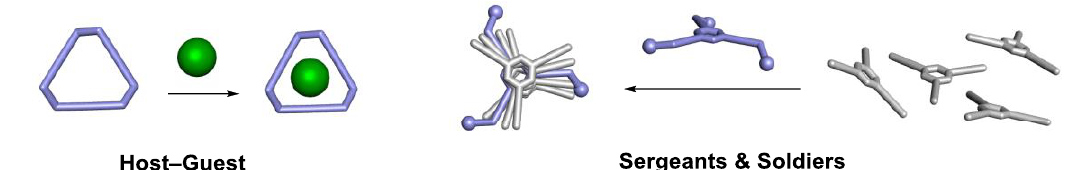
Figure 7. Representation of host–guest and sergeants and soldiers strategies for chiral induction.